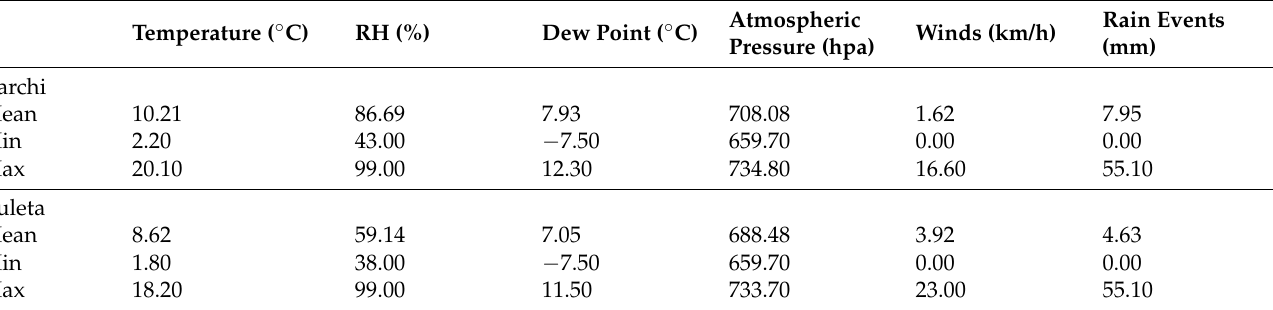
Table 2. Environmental conditions of the localities where the fruits of the wild Andean blueberry ( V. floribundum Kunth) were